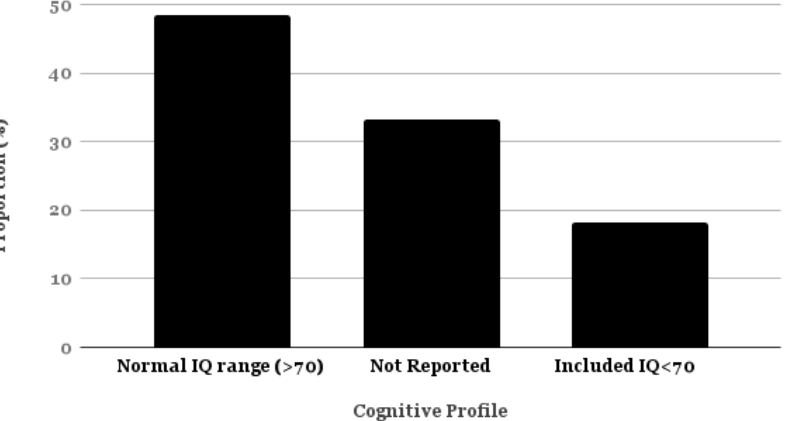
Figure 4. Proportional Table–Studies by Cognitive Profile ( n = 66).